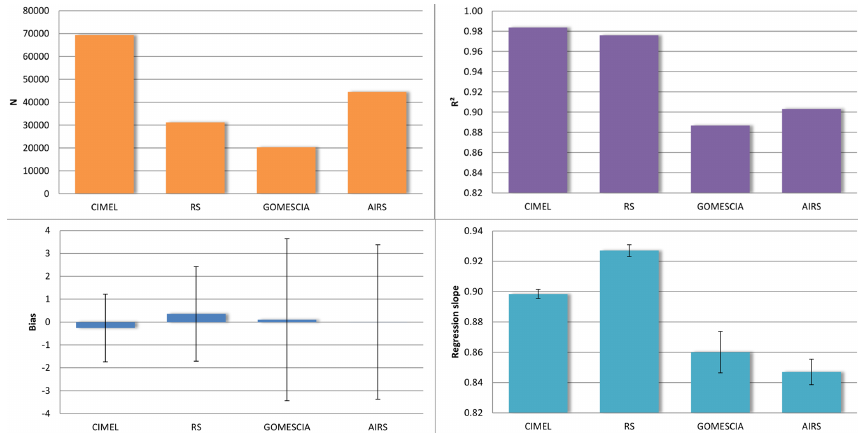
Figure 13. Column bar plots of scatter plot properties (count N , bias, R 2 and regression slope) of the different instruments versus GPS averaged over all stations included in the intercomparison. Error bars: see Fig.